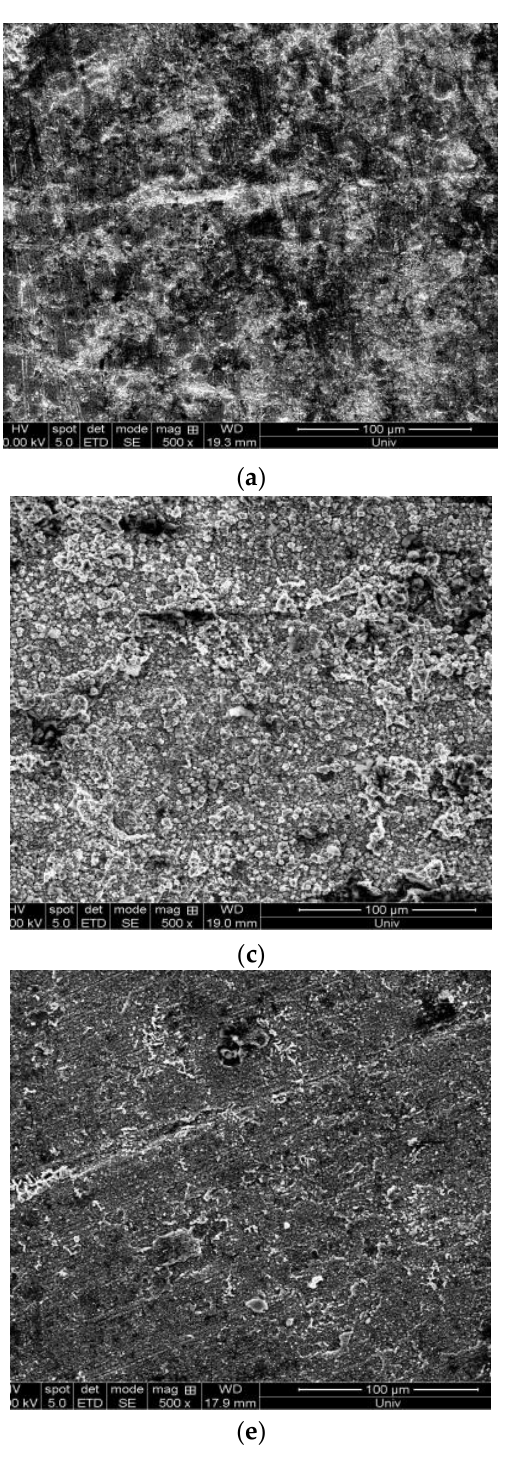
Figure 6. Surface morphology of the deposition layer under different current waveforms and current densities. ( a ) is DC electrodeposition, 120 mA·cm −2 , ( b ) is Bidirectional pulse electrodeposition, 120 mA·cm −2 , ( c ) is DC electrodeposition,150 mA·cm −2 , ( d ) is Bidirectional pulse electrodeposition, 150 mA·cm−2, ( e ) is DC electrodeposition, 200 mA·cm −2 and ( f ) is Bidirectional pulse electrodeposi- tion, 200 mA·cm −2 .